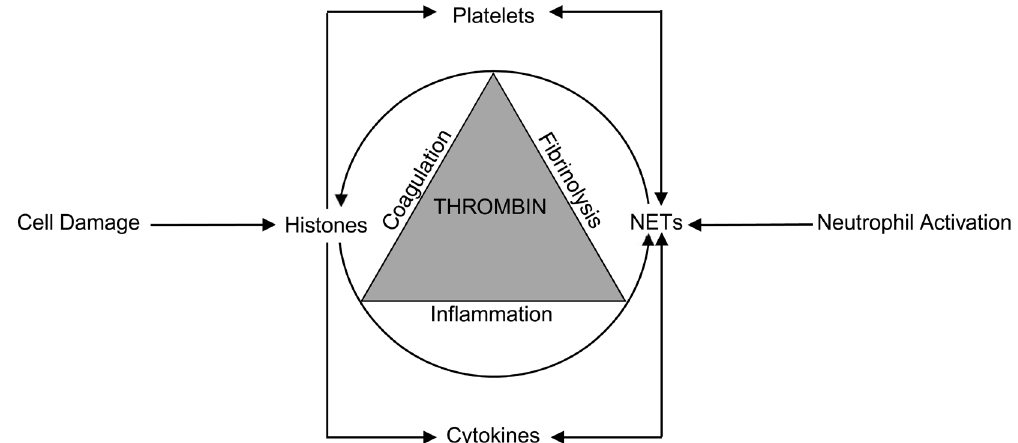
Figure 1. Bi-directional relationship between histones and neutrophil extracellular traps (NETs). Cell damage releases histones which trigger NET formation and the formed NETs are a source for both localized and systemic histone release. The increased thrombin generation, which is the hallmark of disseminated intravascular coagulation, simultaneously affects coagulation, fibrinolysis, and inflammation processes to amplify the reciprocal relationship between histones and